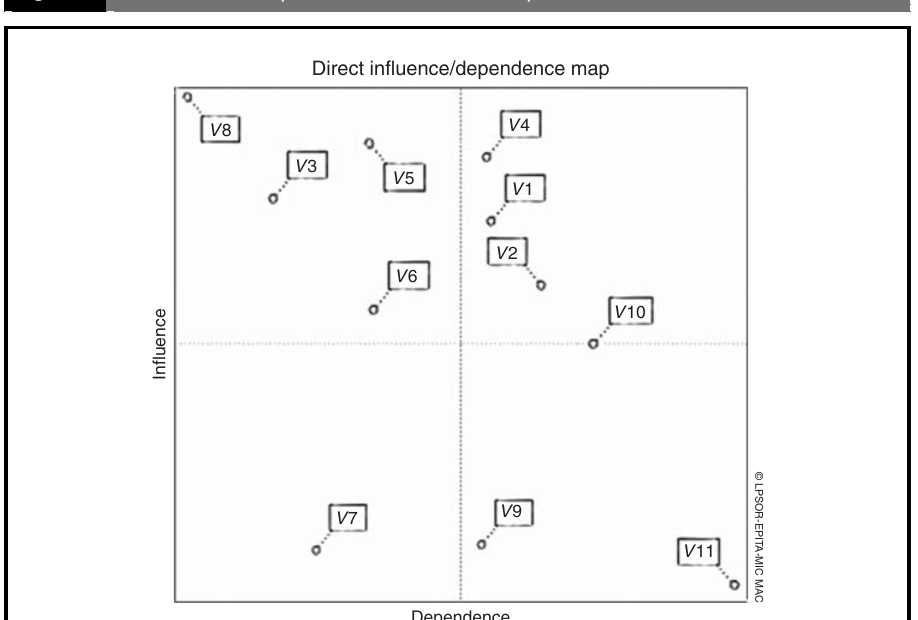
Figure 3 Direct economic positive influence and